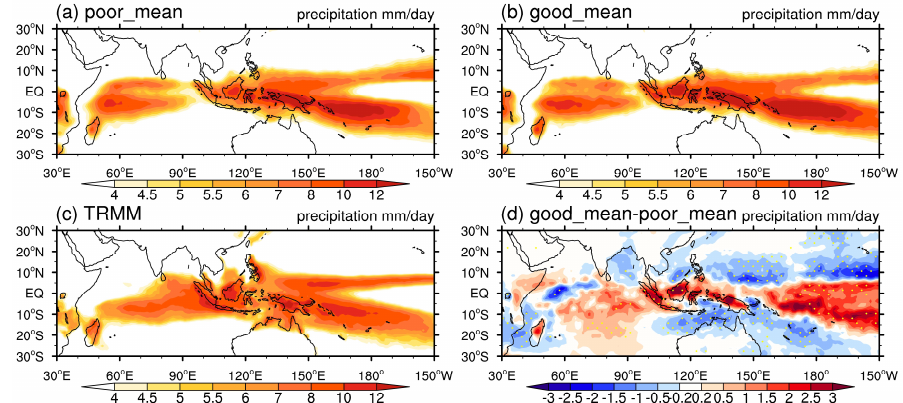
Figure 9. Winter-mean precipitation in ( a ) composite of poor simulations, ( b ) composite of good simulations, ( c ) observation and ( d ) the difference between composites of good and poor simulations with that reaching 90% confidence level dotted.